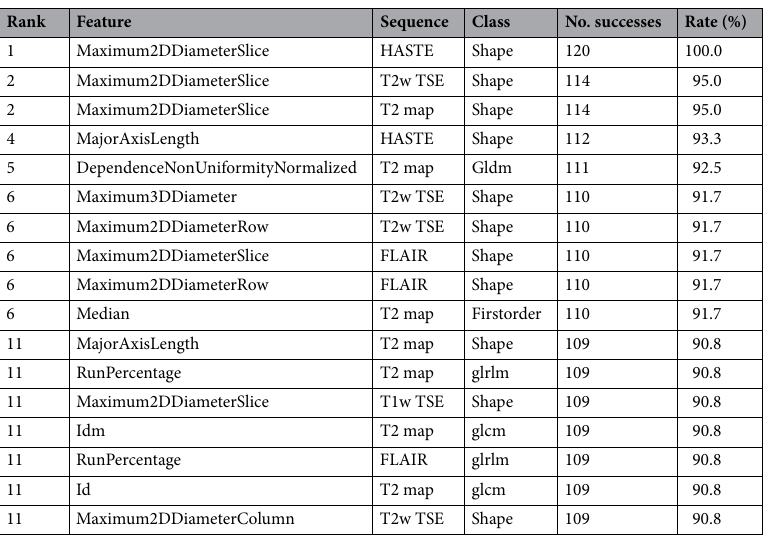
Table 3. Top ranked features by number of pairwise discriminative successes based on Gini score analysis. The 17 top ranked features up to a cut-off value of 109 successes are depicted to pairwise discriminate variant fruits. See supplementary Table 2 (Table D.1) for all